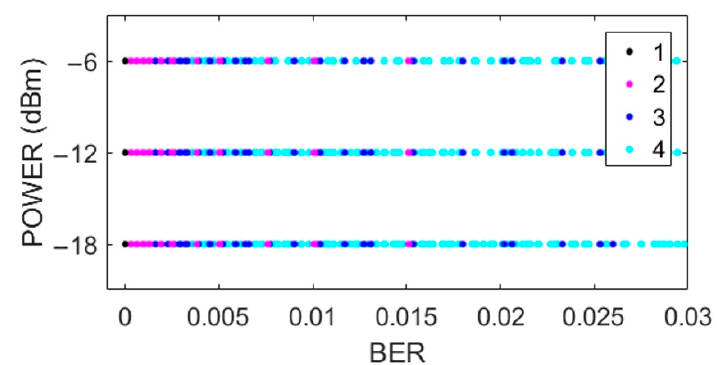
Sensors 2022 , 22 , x FOR PEER REVIEW Figure 4. Scatterplot of transmission power against BER. Figure 4. Scatterplot of transmission power against BER. Figure 4. Scatterplot of transmission power against BER. Figure 4. Scatterplot of transmission power against BER.